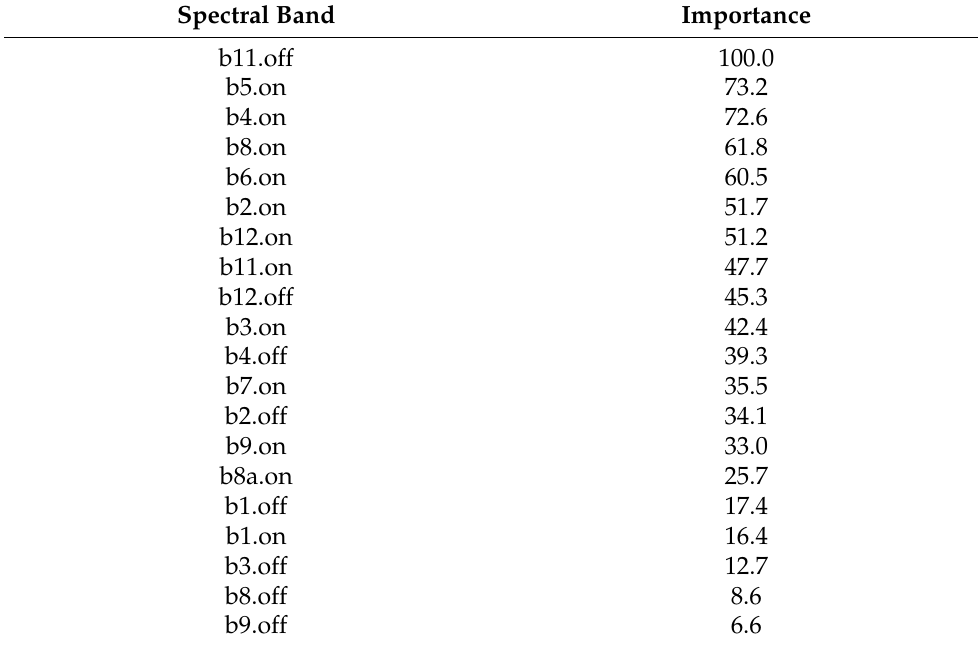
Table 1. Scaled variable importance of spectral bands contributing to the random forest regression model used to train, validate, and spatially predict fine-fuels across BANWR (off = vegetation dormancy, on = peak vegetation